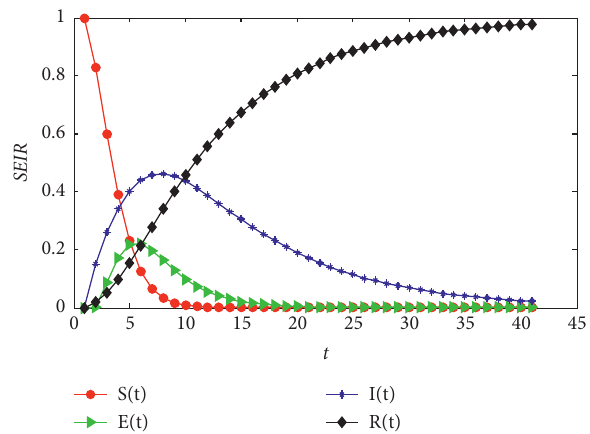
Figure 6: Change trend of SEIR model (1) (when μ 1 � 0.7, μ 2 � 0.1, μ 3 � 0.02, α � 0.2, and c � 1, the change of four independent states of the credit subject trend over